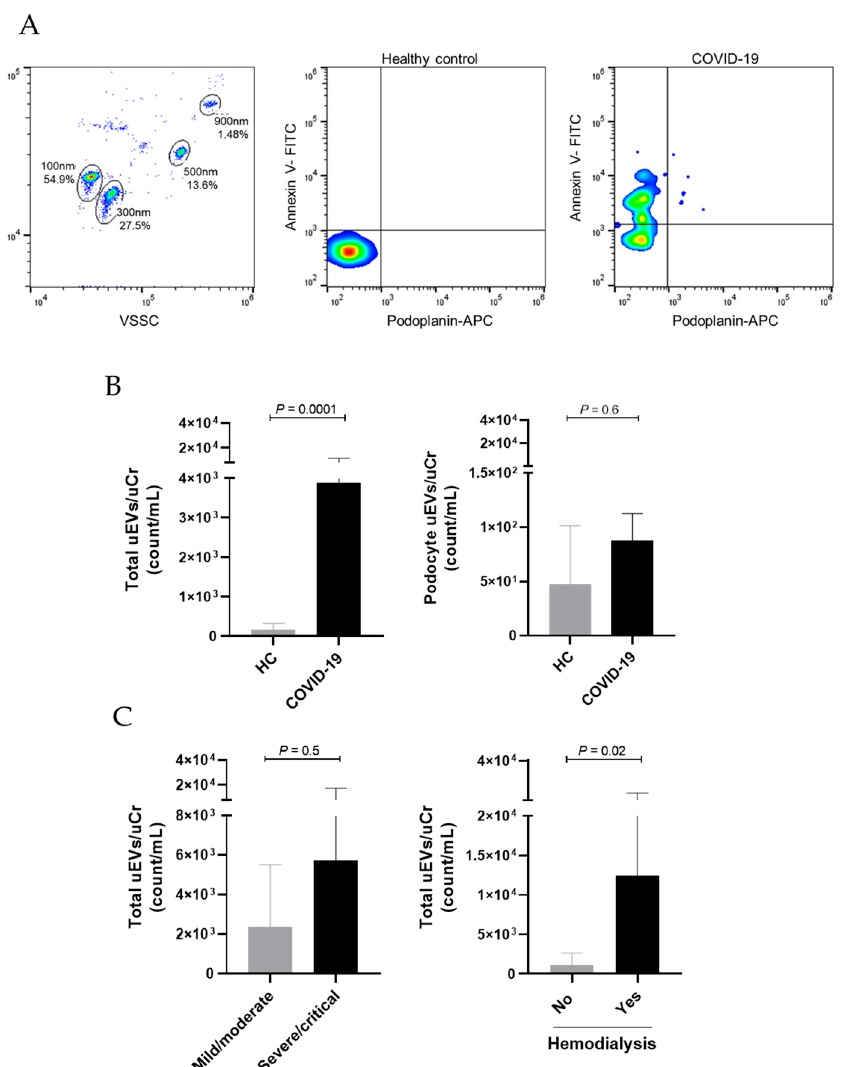
Figure 1. Urinary total and podocyte-derived EVs in COVID-19 hospitalized patients and healthy controls. ( A ) Flow cytometry gating strategy shows EV identification based on calibration with size beads (100 nm–900 nm) and representative dot plots demonstrate the characterization of total uEVs (Annexin V + ) and podocyte-derived uEVs (Annexin V + Podoplanin + ) in a healthy control (HC) and in a patient with COVID-19. ( B ) Comparison of uEVs between HC and COVID-19 patients. ( C ) Comparison of total uEVs according to COVID-19 severity and need for hemodialysis. Differences between groups were assessed using Mann–Whitney